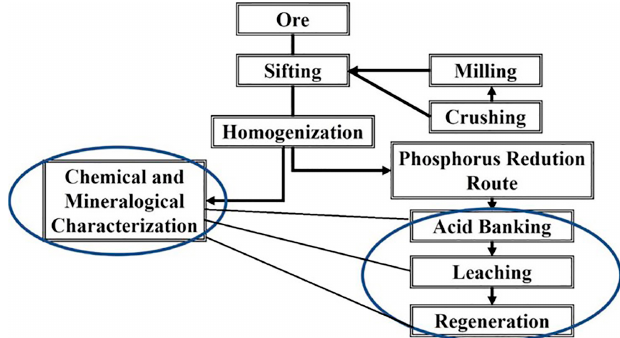
Figure 6. Process route for the remotion of phosphorus content using microwave energy using acid baking followed by